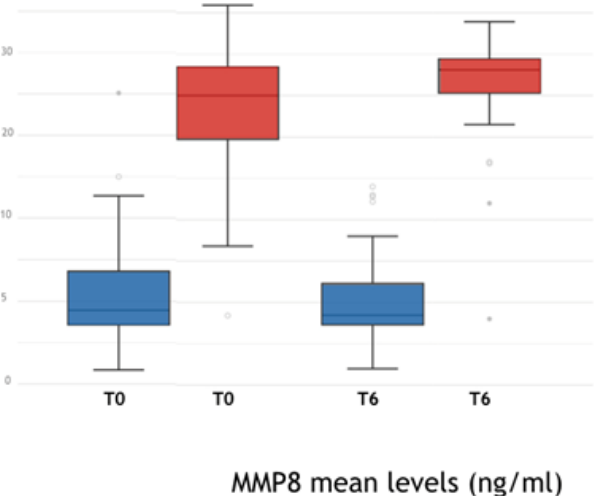
Figure 5. Mean MMP-8 levels recorded around low BLT and high BLT implants at T0 (restoration delivery) and T6 (6 months after functional loading).